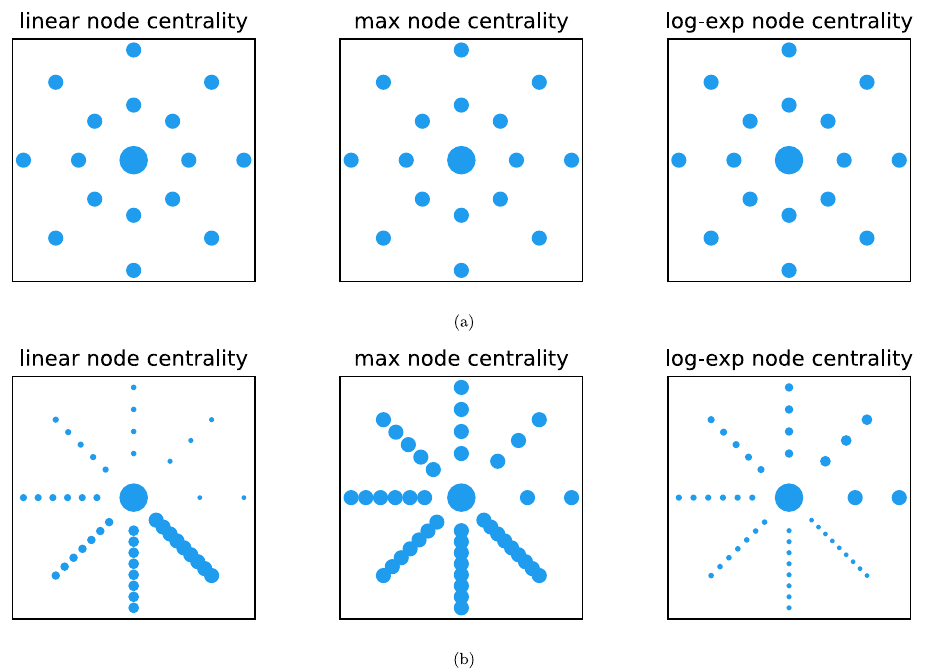
Fig. 1 Example of node centralities on sun fl ower hypergraphs. Node centrality scores for the "linear'', "log-exp'', and "max'' centrality models on the two example hypergraph sun fl owers. The corresponding centrality model is speci fi ed on top of each panel. Dots represent the hypergraph nodes and their size is proportional to their centrality value. a Shows results on a uniform sun fl ower with eight petals each containing three nodes; b shows results on a hypergraph sun fl ower with eight petals containing 3, 4, … , 10 nodes,